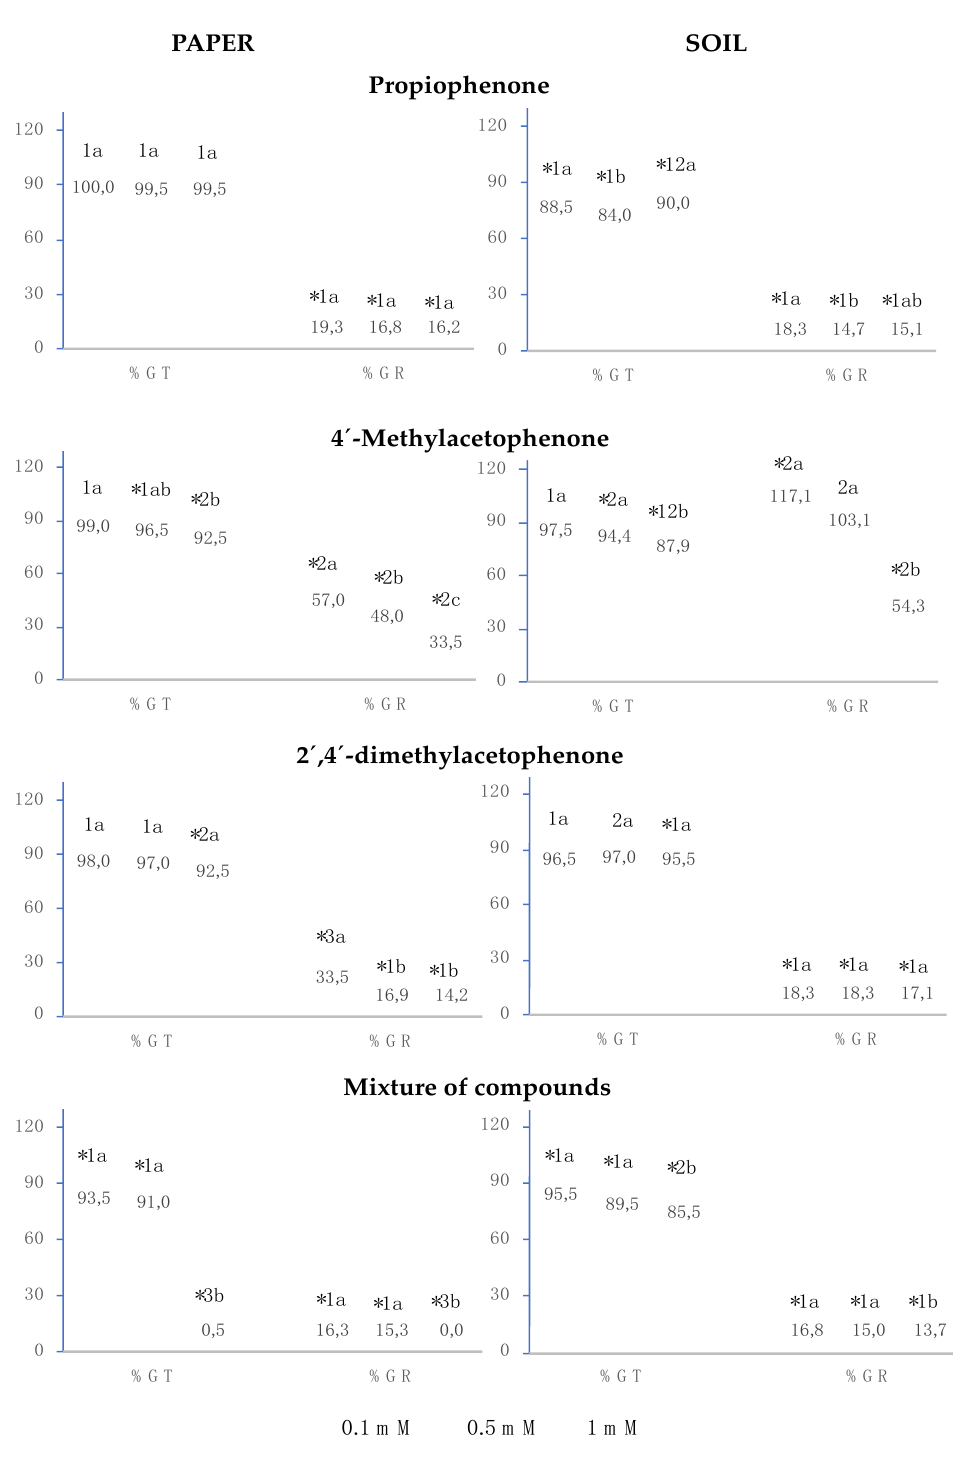
Figure 2. The effect of different concentrations of propiophenone, 4 ′ -methylacetophenone, 2 ′ ,4 ′ -dimethylacetophenone, and the mixture of the three compounds on the total germination (%GT) and germination rate (%GR) of Lactuca sativa , expressed as the percentage relative to the control. Four replicates of each treatment were performed (n = 4 × 50 = 200 seeds in total for each solution). * Significantly different from the controls; 1, 2, 3: differences numbers indicate significant differences between treatments of the same index and for each concentration. a, b, c: differences in small letters indicate significant differences between concentrations of the same index and for each treatment. p < 0.05 (Mann–Whitney U